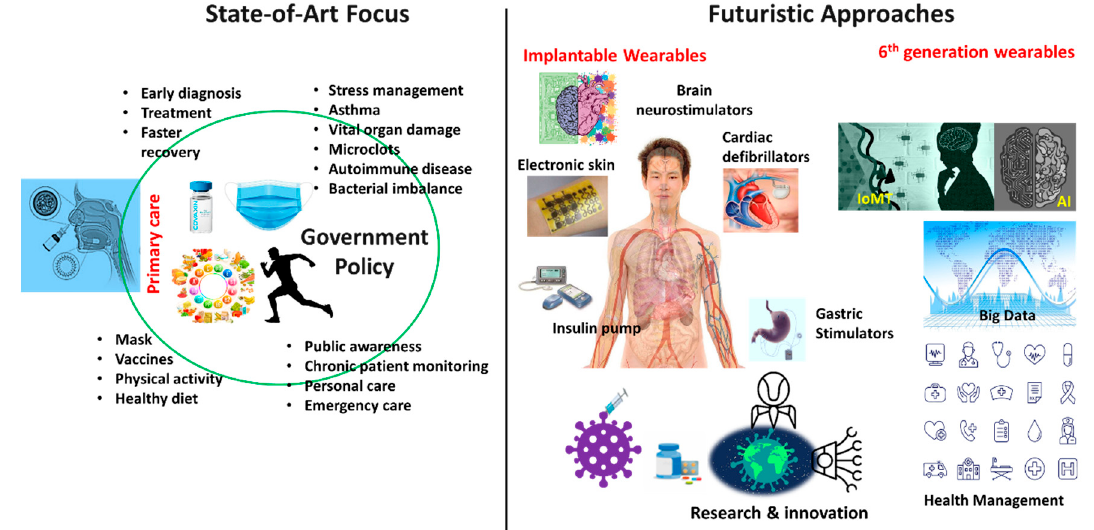
Figure 4. Depicting the future approach for management of long COVID through implantable wearables based on digital health care (IoMT and AI based cloud computing), and show a government focus on awareness, research, personal medicine, etc.